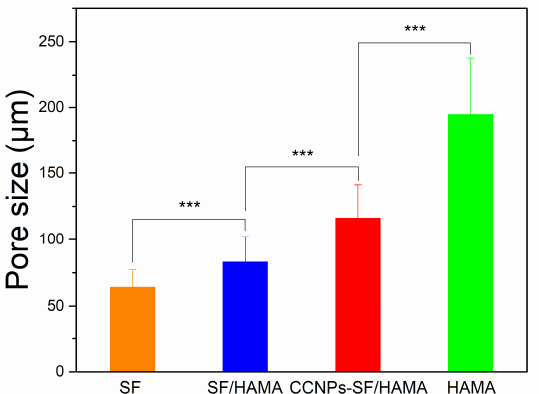
Figure 4. Pore size of CCNPs-SF/HAMA hydrogels *** p < 0.001 are differences between the indi- cated groups.